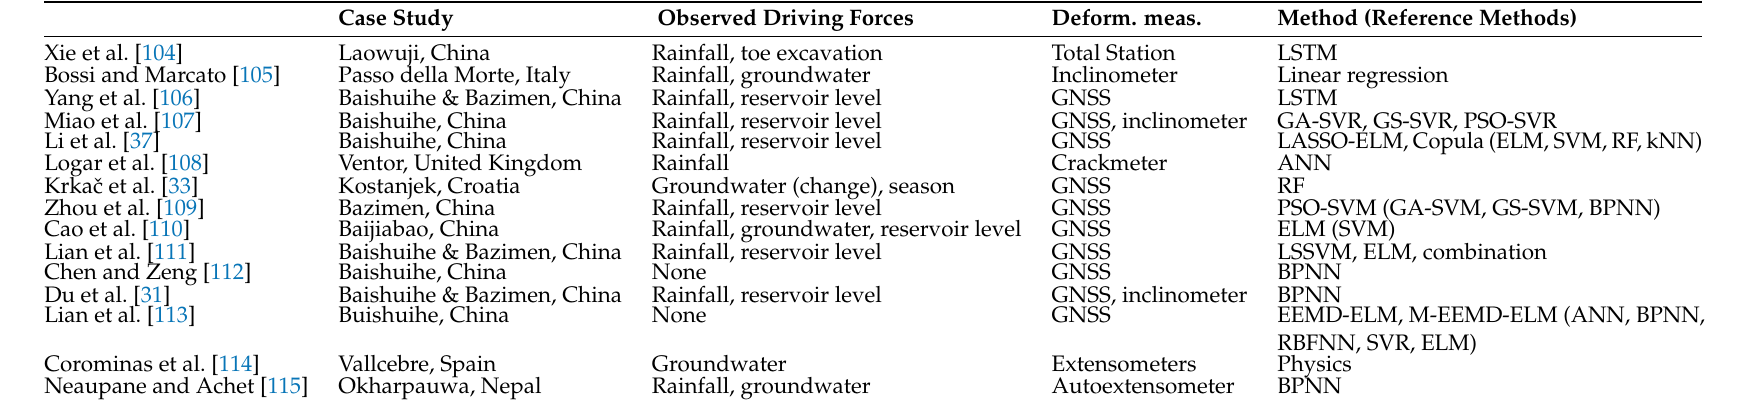
Table 4. Examples of different integration methods, linking hydro-meteorological conditions to deformation time series, and associated case studies. Where applicable, the reference methods used in the paper are listed in brackets. Relevant abbreviations are expanded in the